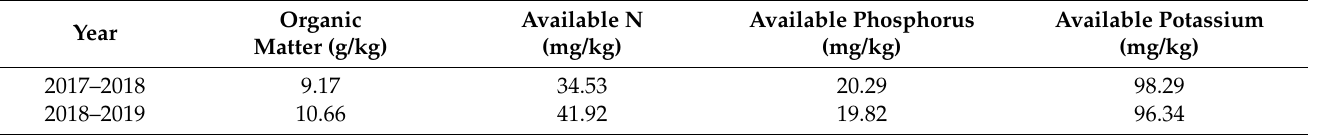
Table 2. Soil essential nutrient content of 0–20 cm layer at the experimental site in two